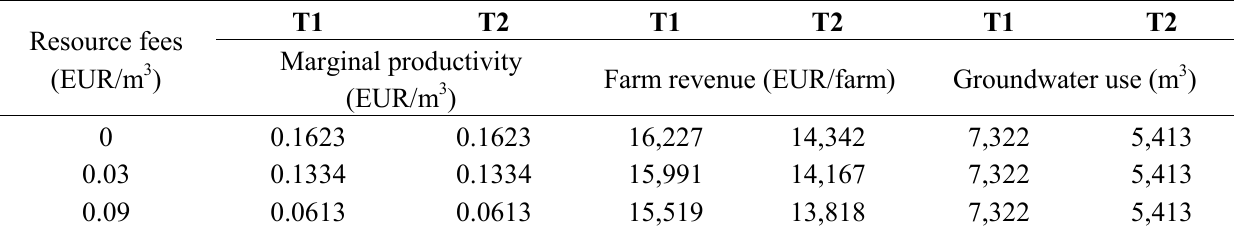
Table 6. Farms’ performances under the Regional market (B)